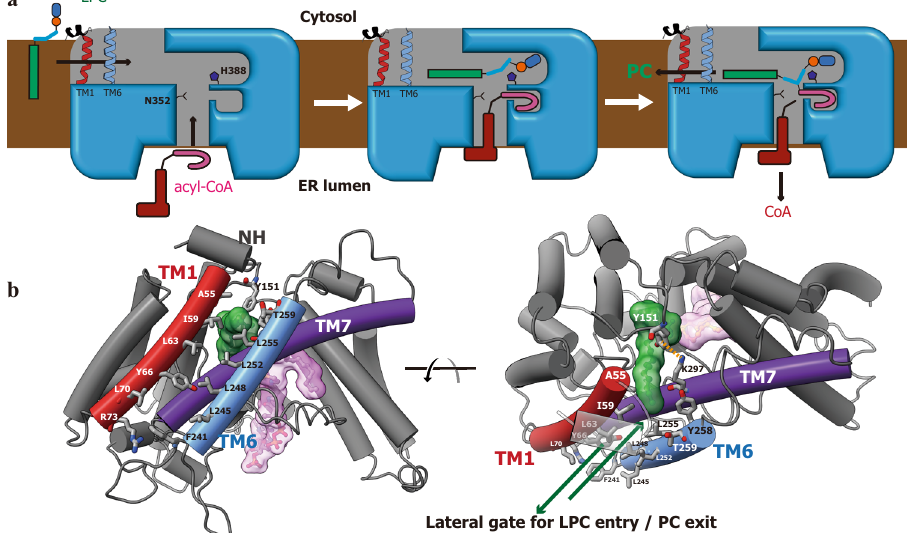
Fig. 5 The working model for LPCAT3. a The cartoon representation about the enzymatic operation of LPCAT3. The whole reaction cycle includes three states: substrate-capture (left), acyl transferring (middle), and product release (right). b Close views on the lateral gate for LPC entry and PC exit from two angles. The LPC molecule bound was shown as a stick-and-ball model covered by green surface. The residues from TM1 and 6 lining the lateral gate were shown and labeled. The Y151-K297 pair functions as a lock for the gate through their cation-aromatic interaction (orange dot of sn-2 hydroxy and carbon of protonated carbonyl, followed by the passage of PC/LPC. An even higher rise in enzymatic activity the breakage of the thioester bond to release the PC product from was found on cLPCAT3 K297A, which could relieve the steric the intermediate. In the end, the CoA molecule thereby formed hindrance from the cation-aromatic interaction between Y151 exits from the vertical tunnel into the ER lumen, while the PC and K297 (Fig. 5b). molecule might enter the ER membrane through the lateral gate When studying DGAT1 in the acyl donor-bound state, Sui (Fig. 5a, b). The enzymatic activity of LPCAT3 was improved by et al. showed a lipid-like density co-localized in the reaction the mutations on the residues at the lateral gate, e. g., I59A chamber which might represent the DAG molecule as the acyl (Figs. 3d and 5b), implying the gating function of I59 for limiting receptor 36 . In our EM map for acyl donor-bound state